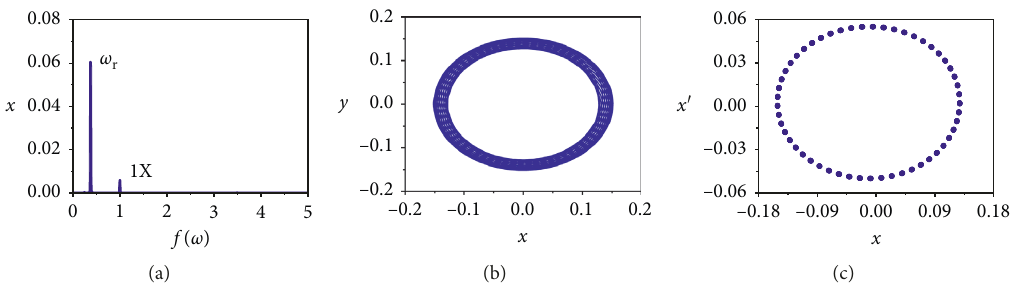
Figure 7: The quasiperiodic response of the rotor/seal system at s rotor. (c) The Poincar´e map of the x